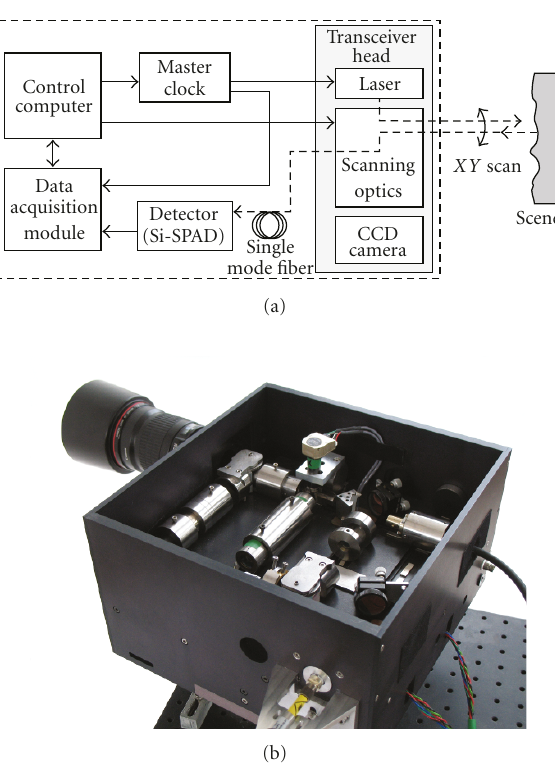
Figure 1: (a) Schematic diagram indicating the principal com- ponents of the scanning system. Electrical paths are denoted by solid lines, optical paths by dashed lines. Si-SPAD is a silicon single-photon avalanche diode. (b) The transceiver head assembly. The system dimensions are approximately 275 mm by 275 mm by 175 mm. The two galvanometer servo-control circuit boards (not visible) are on the underside of the slotted